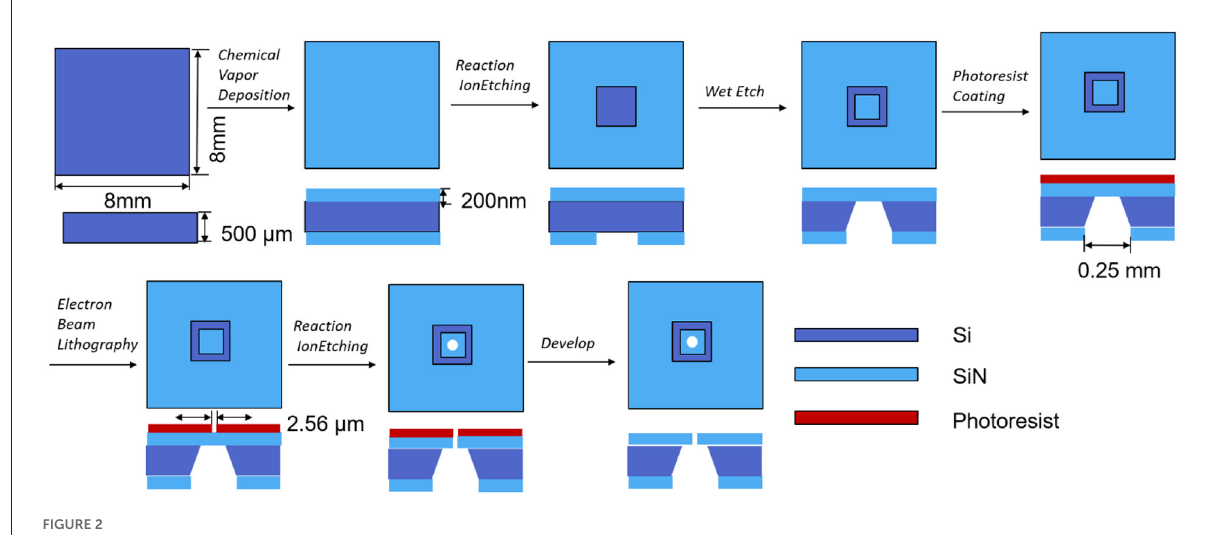
FIGURE2 Fabrication process of SiN